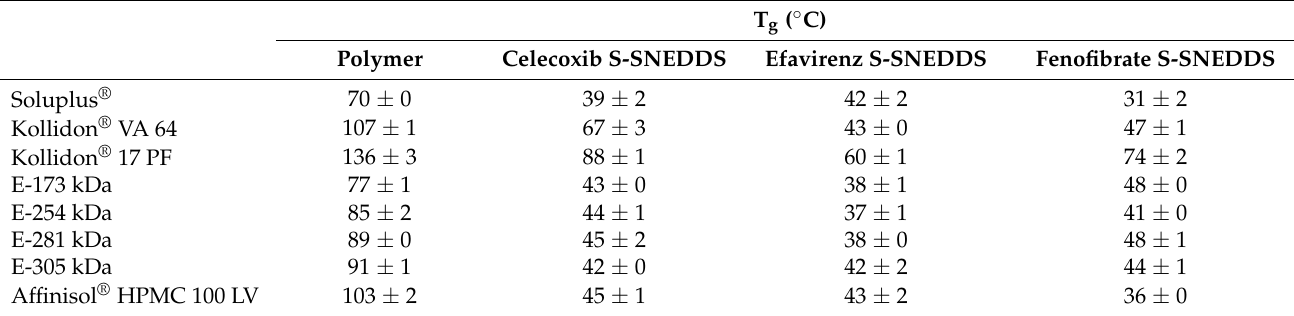
Table 3. Glass transition temperature (T g ) of pure (co)polymers and S-SNEDDS incorporating celecoxib, efavirenz, or fenofibrate. Each value designates the mean ± S.D. ( n = 3). T g ( ◦ C) Polymer Celecoxib S-SNEDDS